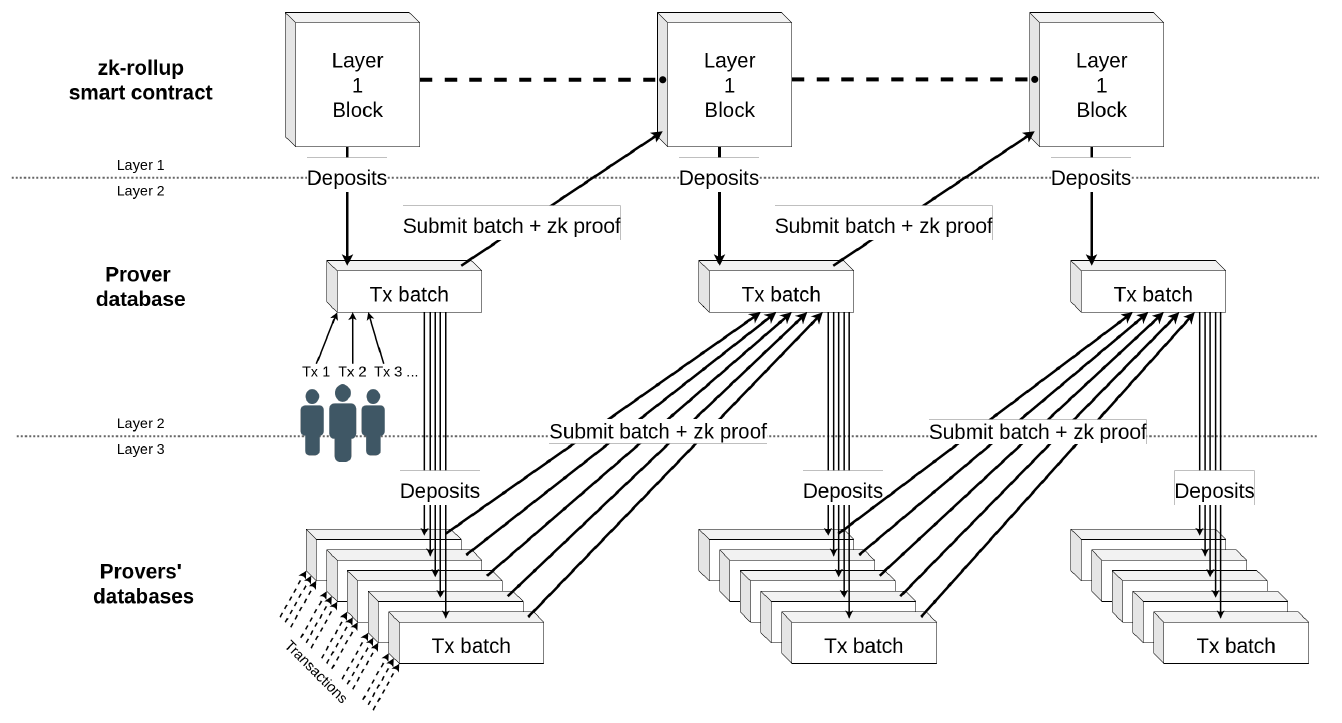
Figure 5. A tree structure of a zk-EVM